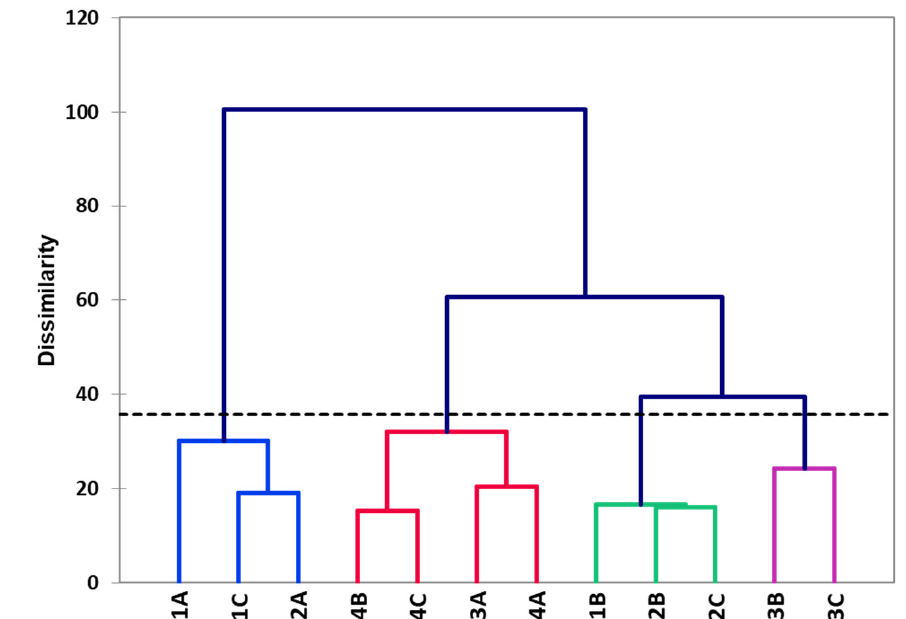
Figure B2. Hierarchical cluster analysis (HCA) conducted on the samples with the NIF values of the 34 OAs determined as discriminant based on 50% NIF difference threshold, displaying four clusters. The data were centered and scaled; dissimilarity Euclidian distances were used with the Ward amalgamation method.